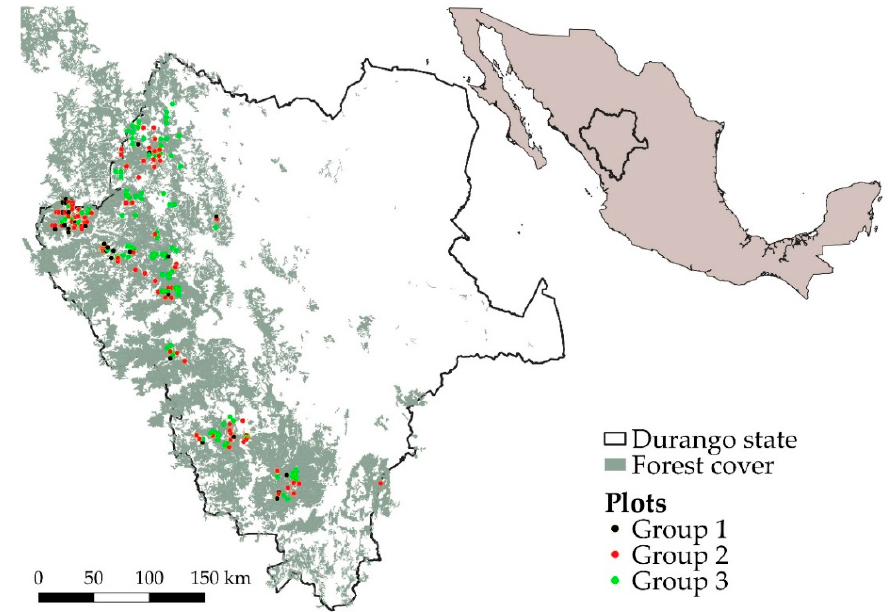
Figure 1. Spatial distributions of field plots by group in the state of Durango. The plots were divided into three groups, which differed in terms of basal area, diameter distribution, and the relationship between number of trees and average tree size. Plot affiliation to a particular group is indicated by one of three groups.